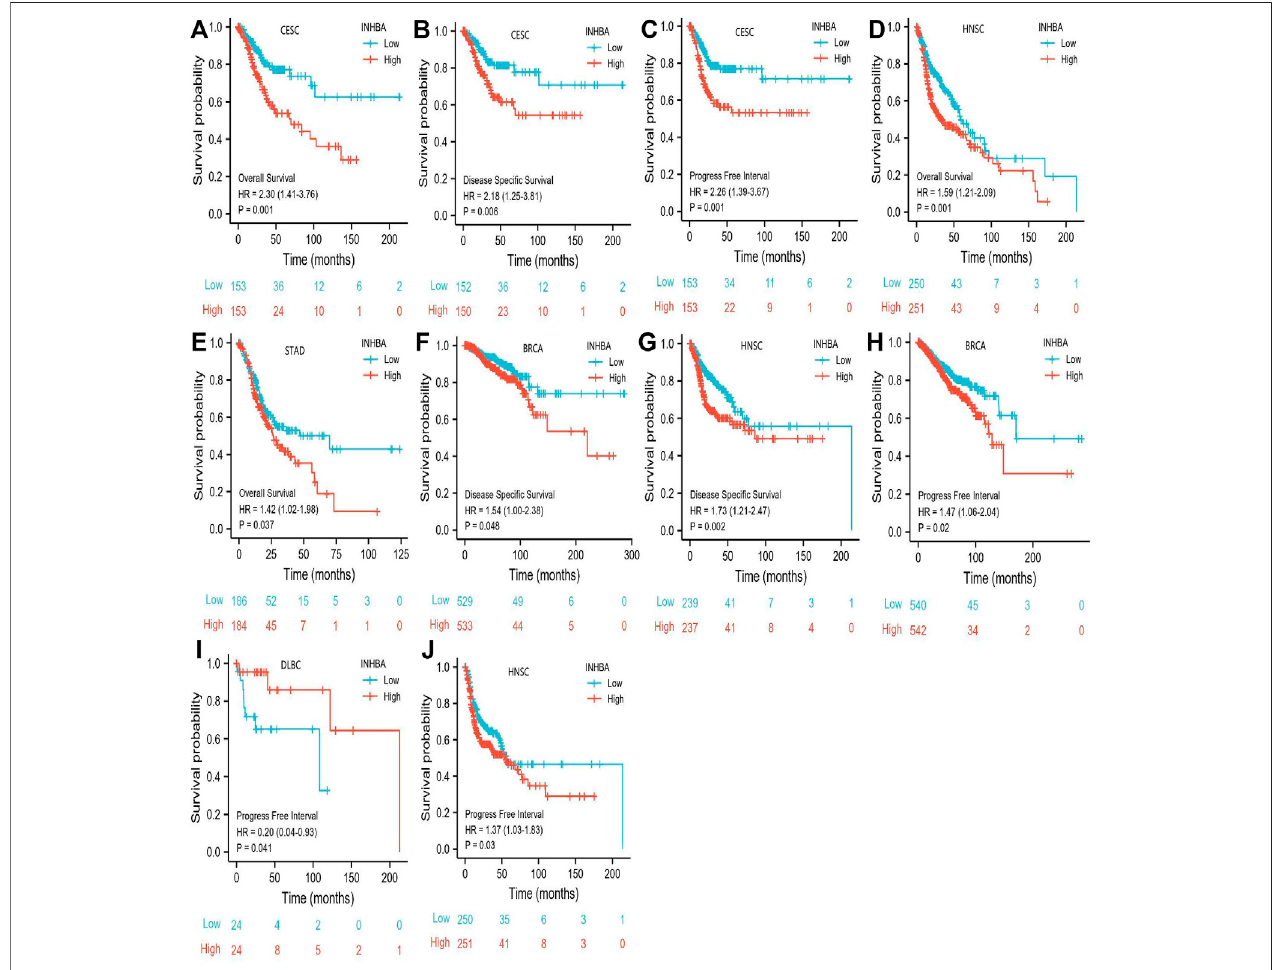
FIGURE 6 | Association between INHBA expression and cancer survival prognosis. (A) CESC INHBA OS Survival. (B) CESC INHBA DSS Survival. (C) CESC INHBA PFI Survival. (D) HNSC INHBA OS Survival. (E) STAD INHBA OS Survival. (F) BRCA INHBA DSS Survival. (G) HNSC INHBA DSS Survival. (H) BRCA INHBA PFI Survival. (I) DLBC INHBA PFI Survival. (J) HNSC INHBA PFI